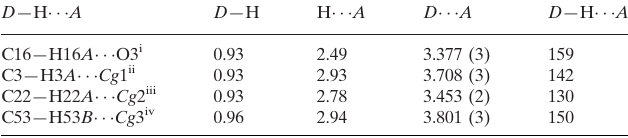
Hydrogen-bond geometry (A˚ , (cid:2)